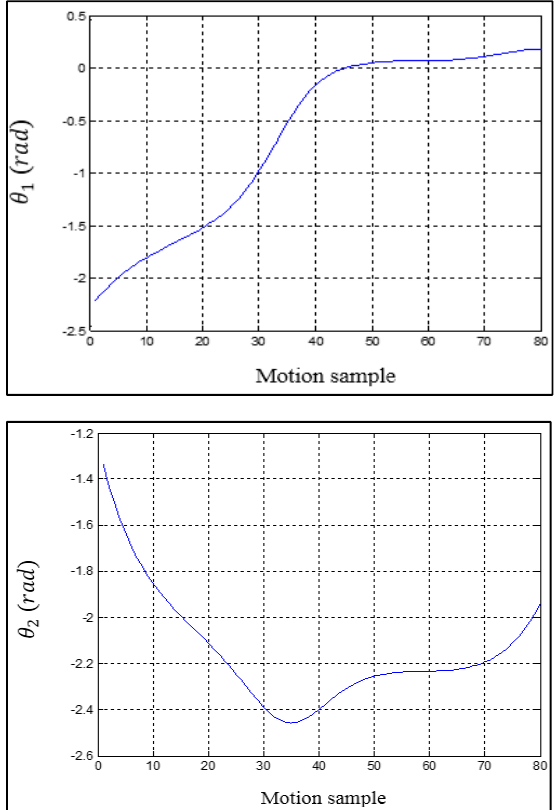
Fig. 10. The first and second angles of the two-link robot arm result for the D*